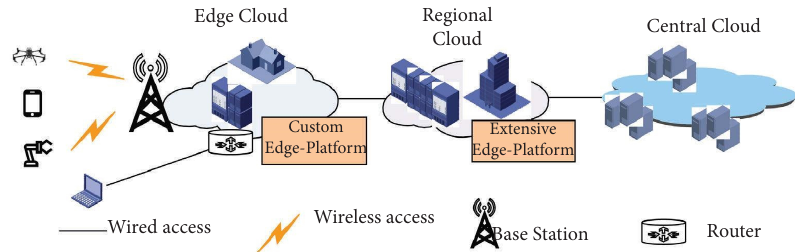
Figure 2: Practical EIRA framework in